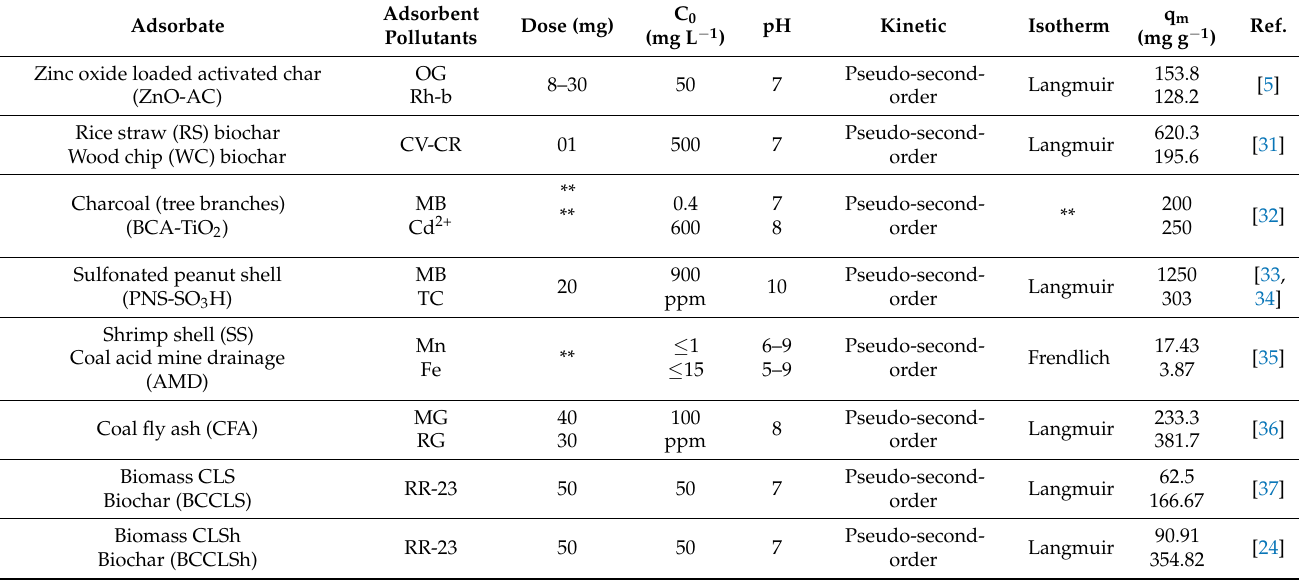
Table 4. The adsorption capacity of dyes and heavy metals in aqueous solutions by activated carbons of different